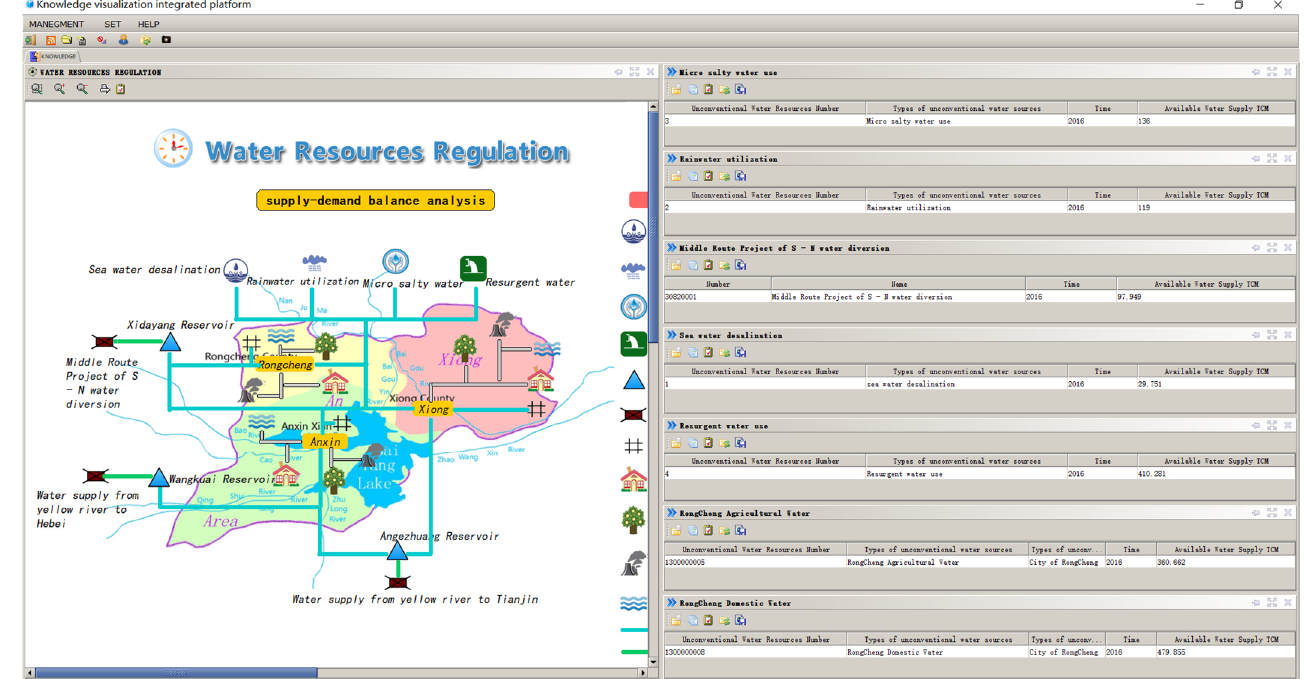
Figure 12. Some results of the visual knowledge map of water resources regulation.